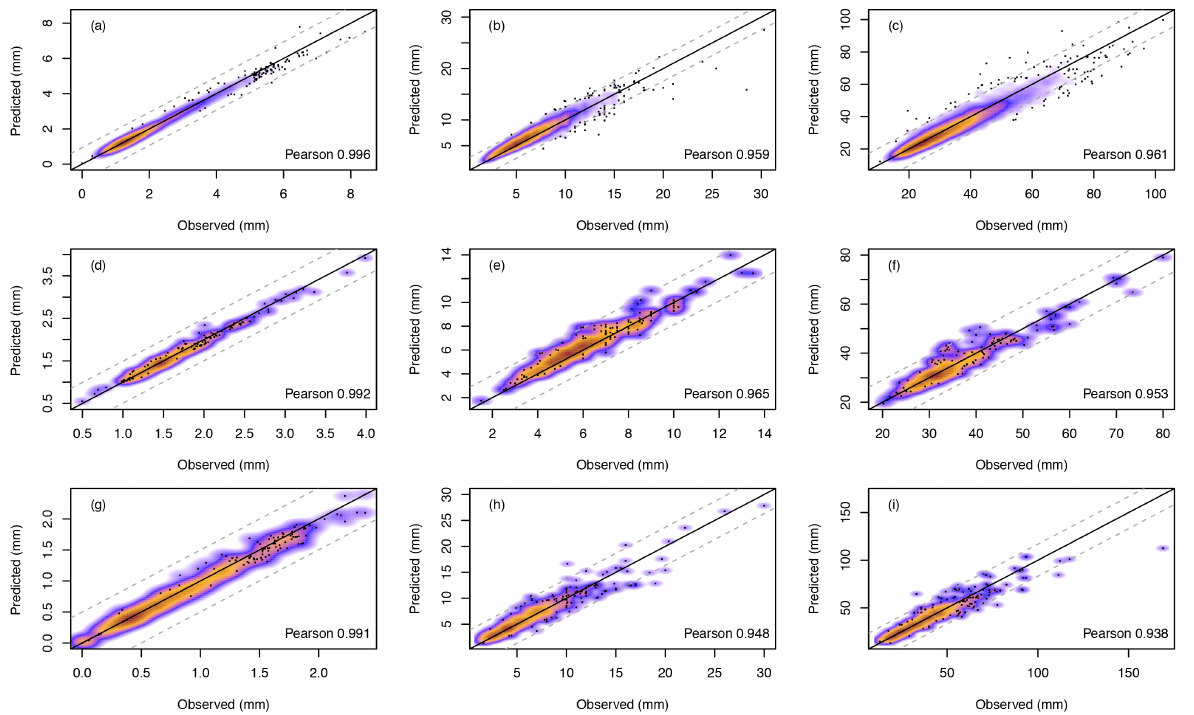
Figure 3. Scatterplots and Pearson correlation coefficients between observations and estimations of daily precipitation in peninsular Spain (upper line; a, b c ), Balearic Islands (midline: d, e, f ) and Canary Islands (bottom line: g, h, i ). Dots represent the stations and colours indicate the density. Daily precipitation mean (left column: a, d, g ), daily precipitation medians in wet days (central column: b, e, h ) and daily precipitation over 95th percentile (right column: c, f, i ) are